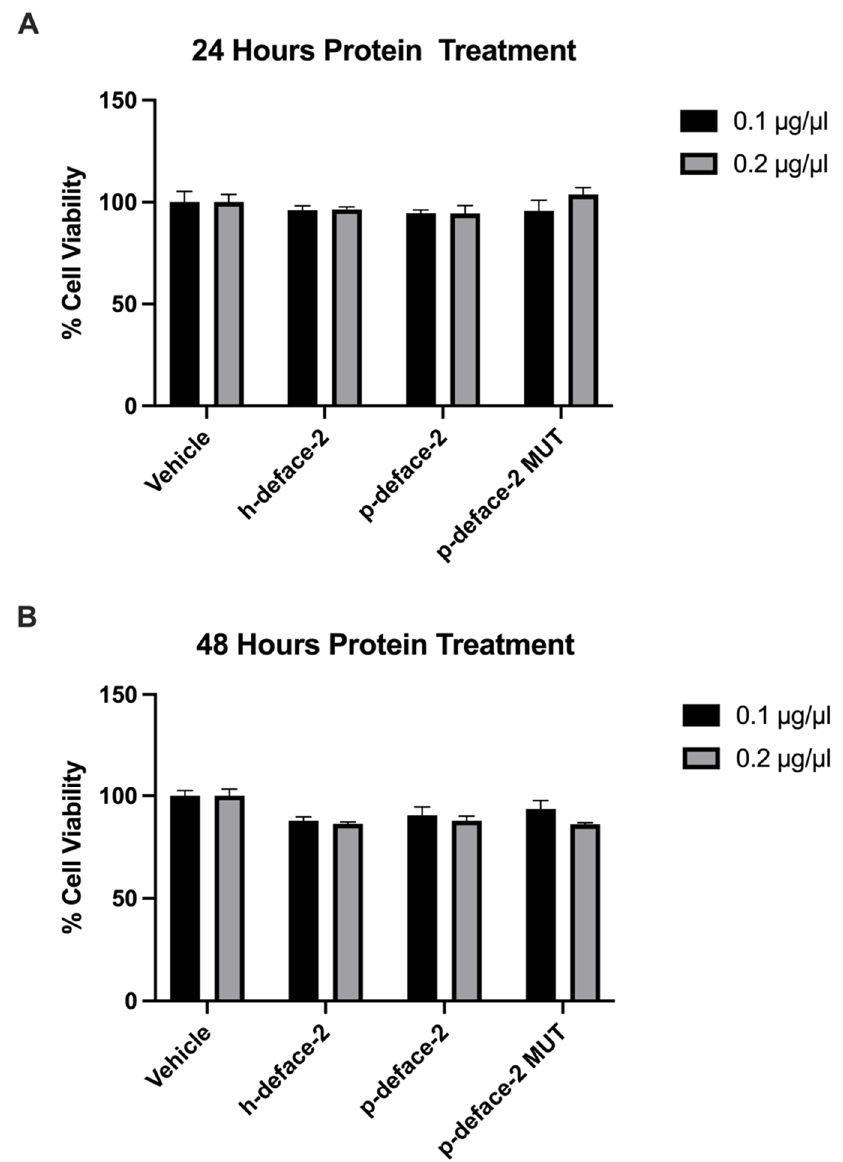
Figure 3. Cell viability assay. 293T cells were treated with h-defaec2, p-deface2, and p-deface2 MUT mini-proteins, and the cell viability was assayed after 24 and 48 h. The percentage of cell viability, which is defined as the percentage fluorescence of protein-treated cells compared to the fluorescence of vehicle-treated cells, is plotted. Experiments were performed in triplicate ( n =